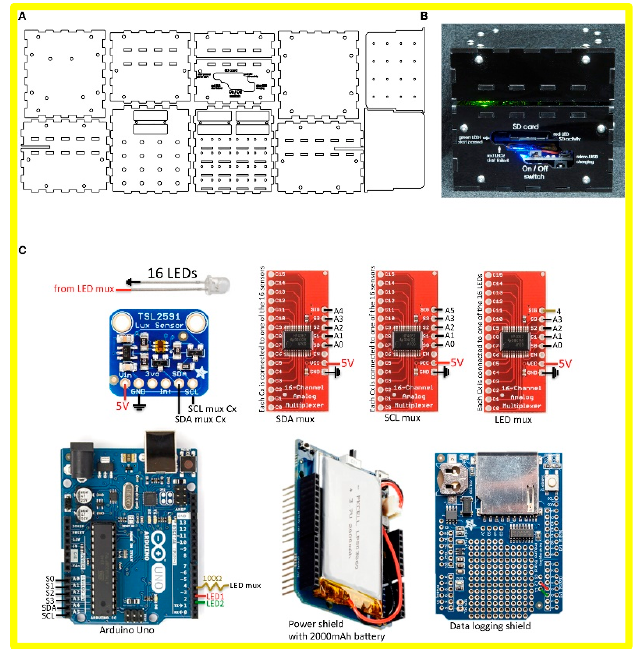
Figure 3. Arduino Uno (marked in the blue square in figure C) used in the work of Pardee, et al . published in Cell 2016 [23]. ( A ) Line drawings used to cut the housing for the electronic reader from black acrylic using a laser cutter. ( B ) Image of the 16-reaction reader from the front. Chip containing paper-based sensors slides into the slot illuminated by the green light. Reader dimensions: 106 mm wide × 116 mm deep × 96 mm high. ( C ) Components and circuit design used to assemble the electronic optical reader. Reproduced with permission from